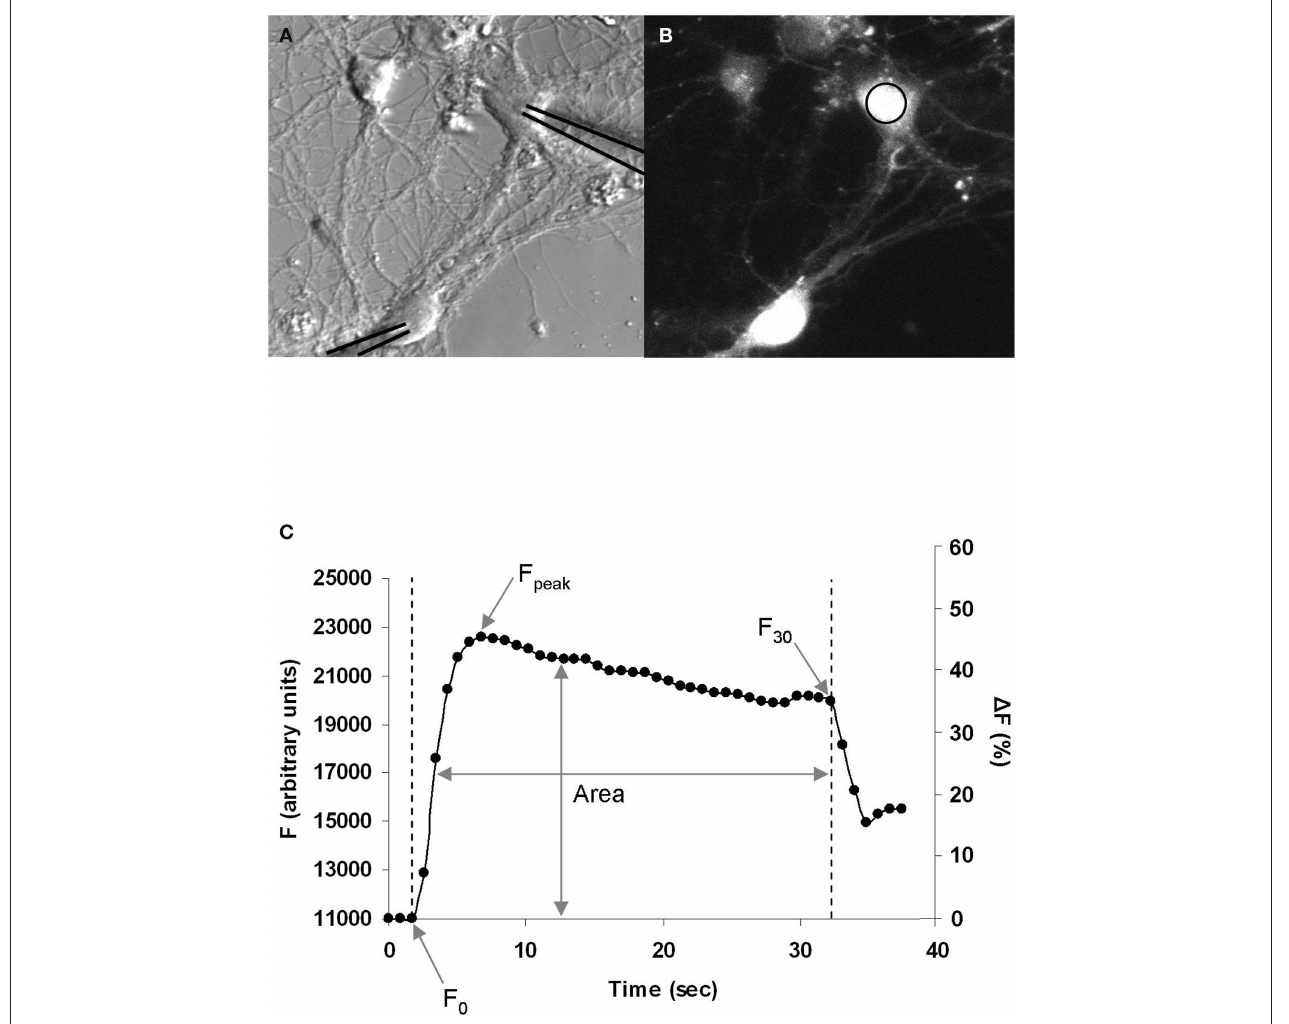
(circle). (C) Example graph of the increase in Fluo4 fluorescence during induction, which begins at F with the onset of stimulation, peaks at F , and ends at F after 0 peak 30 30 s of stimulation. The area of under the curve over this time period was used to calculate F , which normalizes the area to F . Left axis: arbitrary fluorescence units. area 0 Right axis: the same graph expressed as a percentage increase from